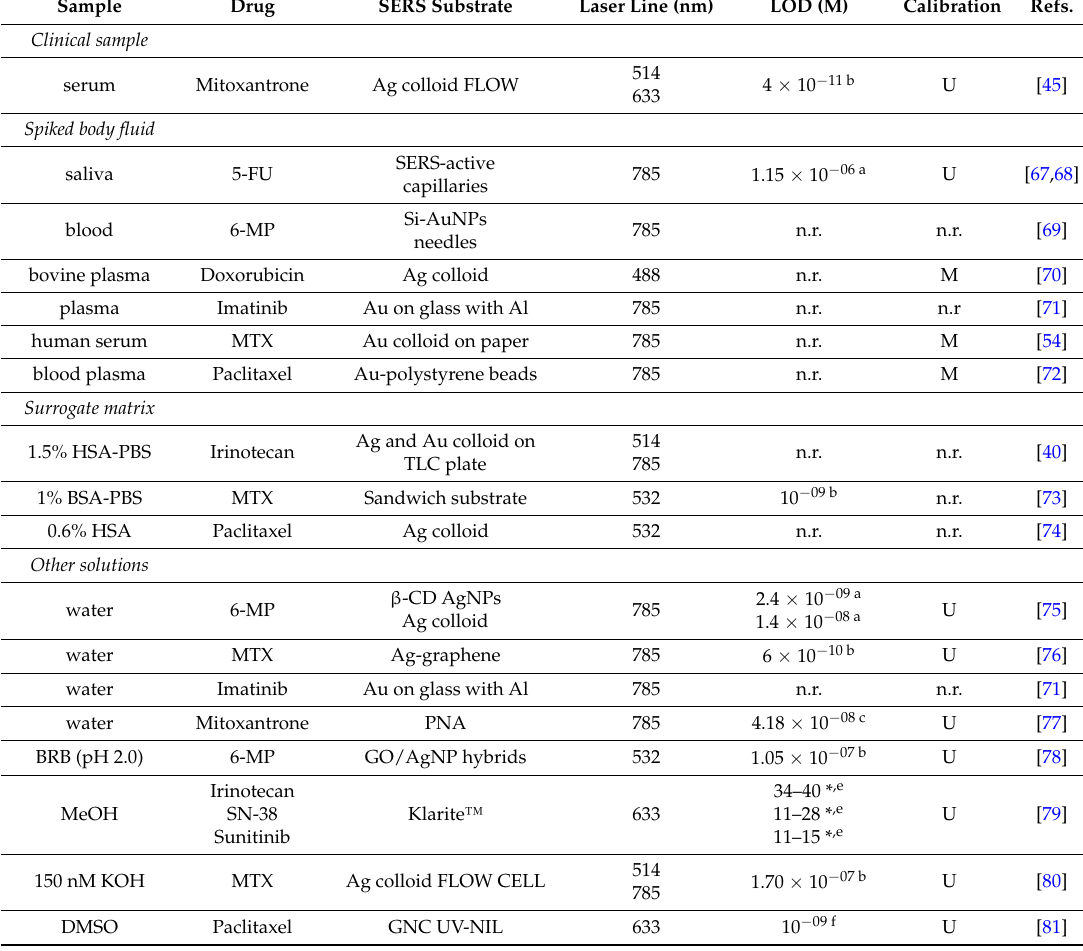
Table 2. Overview of research involving SERS for TDM of various type of chemotherapeutic drugs.